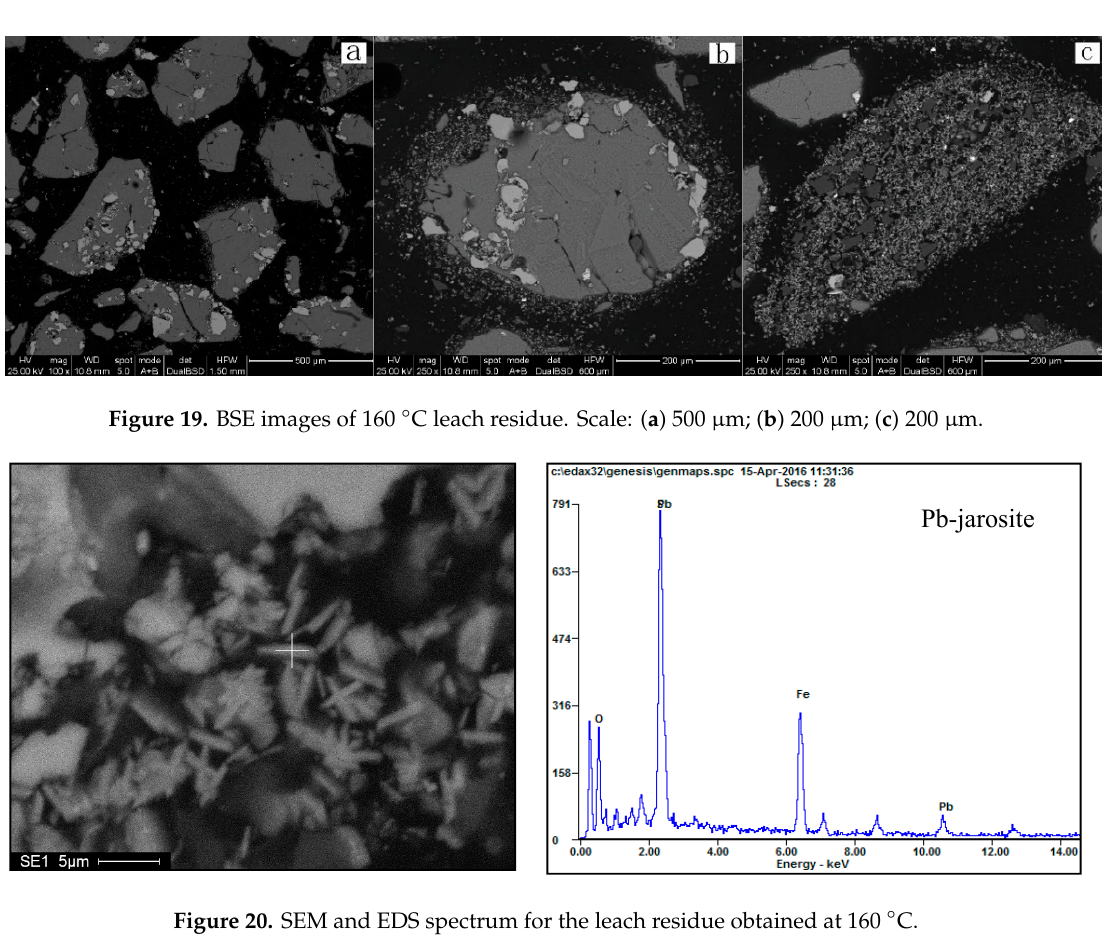
Figure 18. SEM and EDS spectra for the leach residue obtained at 150 °C.